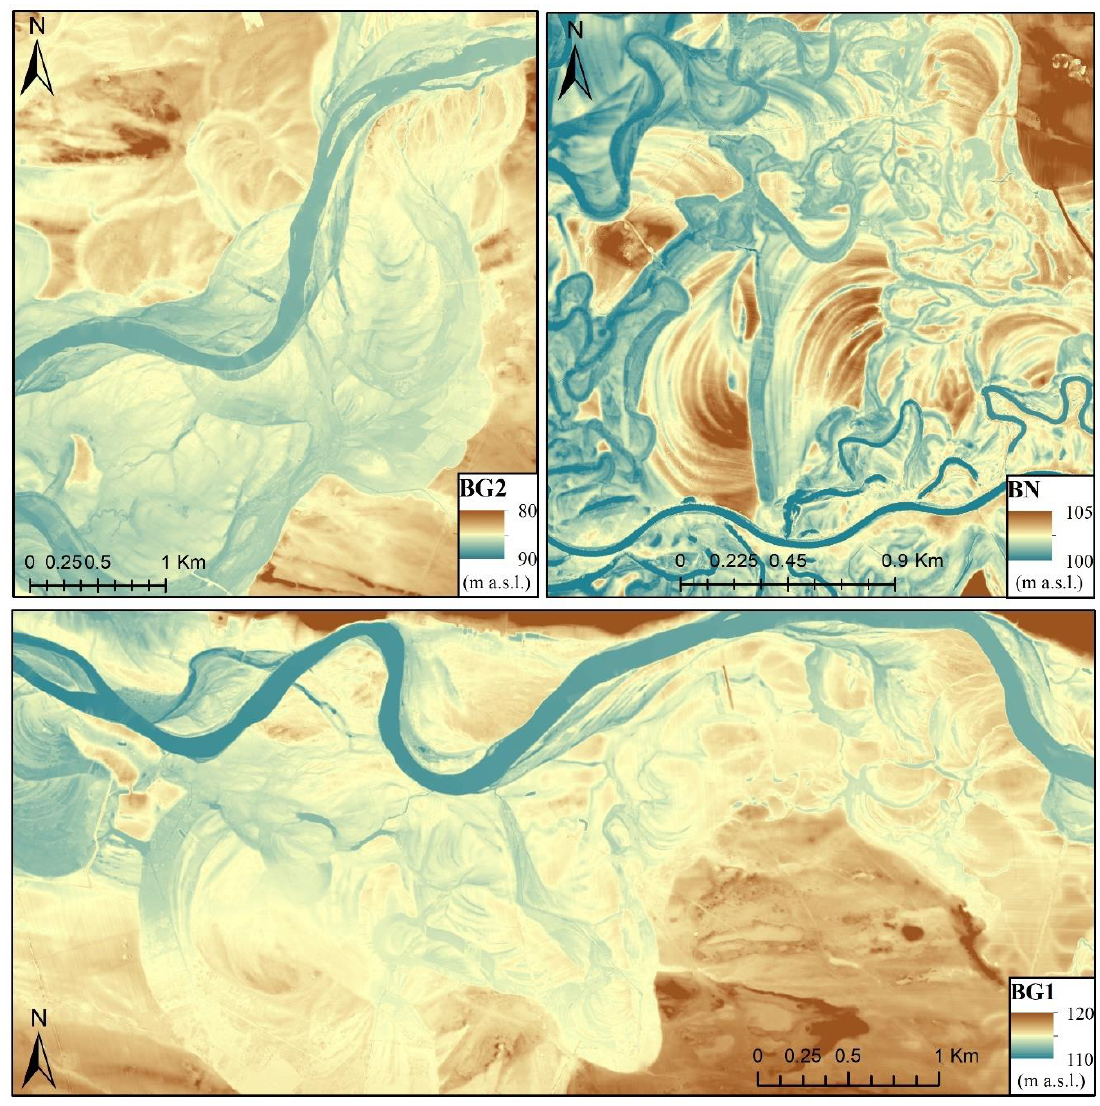
Figure 2. Digital terrain models (DTM) obtained from the airborne laser scanning (ALS) acquisitions, depicting the variable microreliefs among the selected study areas BG2 , BN and BG1 .